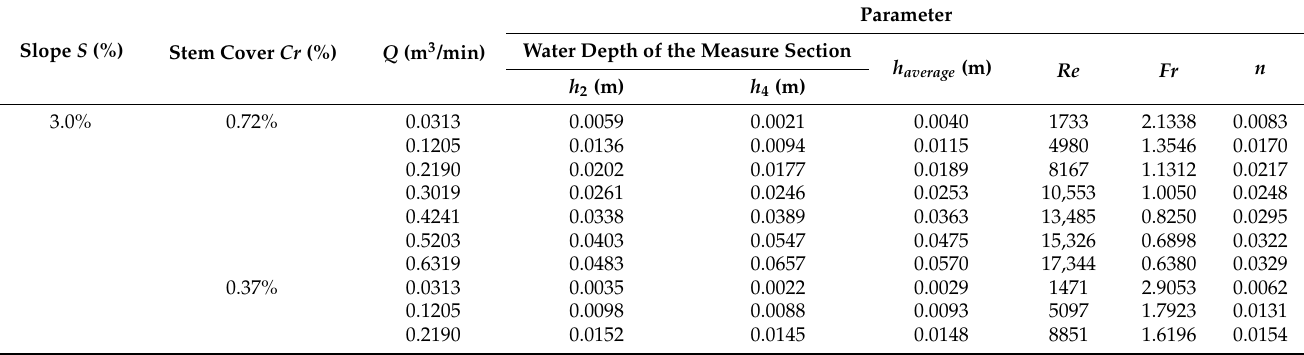
Table 4. Experimental data of hydraulic parameters of six different vegetation stem cover under the condition of S = 3.0% ( Cr is 0.72%, 0.37%, 0.20%, 0.13%, 0.11% and 0.07%,